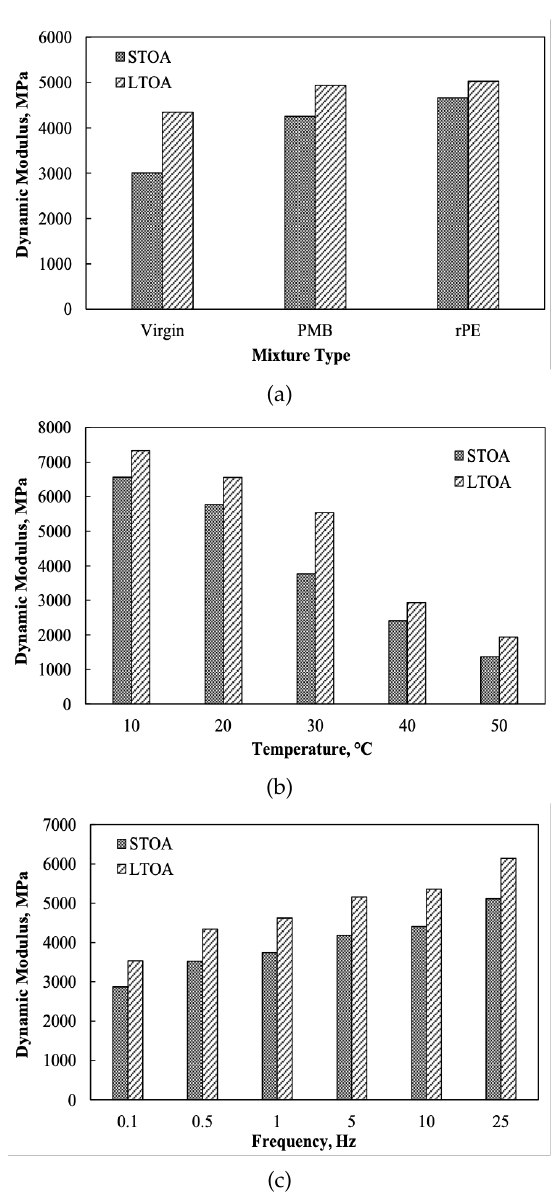
Fig. 5. The influence of aging on the dynamic modulus: (a) compare |E*| of aged mixtures; (b) the effect of aging on |E*| at temperatures; (c) the effect of aging on |E*| at Fig. 6. |E*| LTOA /|E*| STOA for mixtures: (a) virgin frequencies mixtures; (b) PMB mixtures; (c) rPE